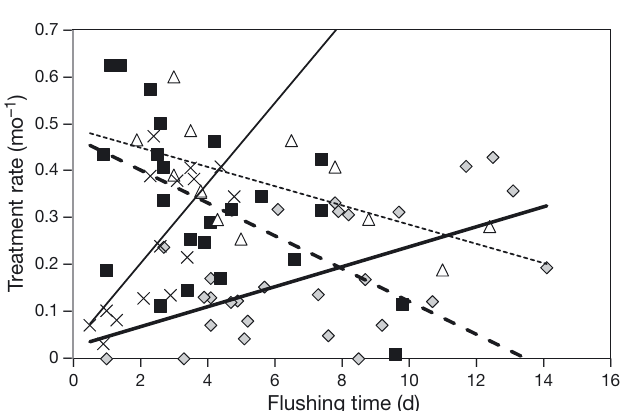
Fig. 6. Associations of sea lice treatment rates with loch turn- over times subdivided by region (see Fig. 1). Grey dia- monds: Northern Isles (thick solid trend = 0.02, r 2 = 0.31), crosses: Western Isles (thin solid trend = 0.085, r 2 = 0.52), solid squares: north mainland (thick dashed trend = −0.02, r 2 = 0.28), and white triangles: southern mainland (thin dashed trend = −0.03, r 2 = 0.36). Trends are with respect to flushing time of the